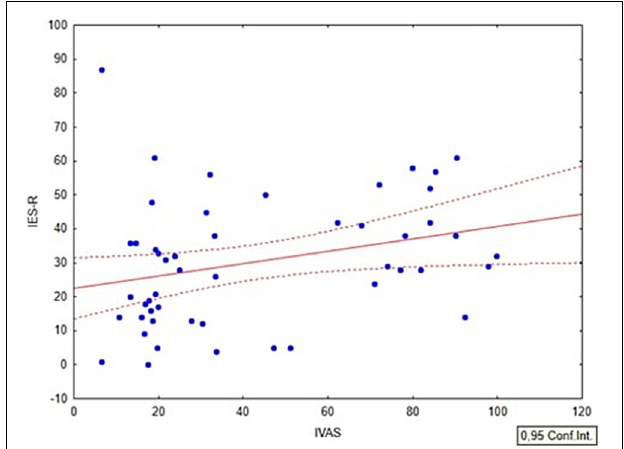
FIGURE 1 | Example of the trials of IVAS. The label “TU” indicates a women participant and the other character on the opposite of the line represents the confederate from which a preferred distance must be